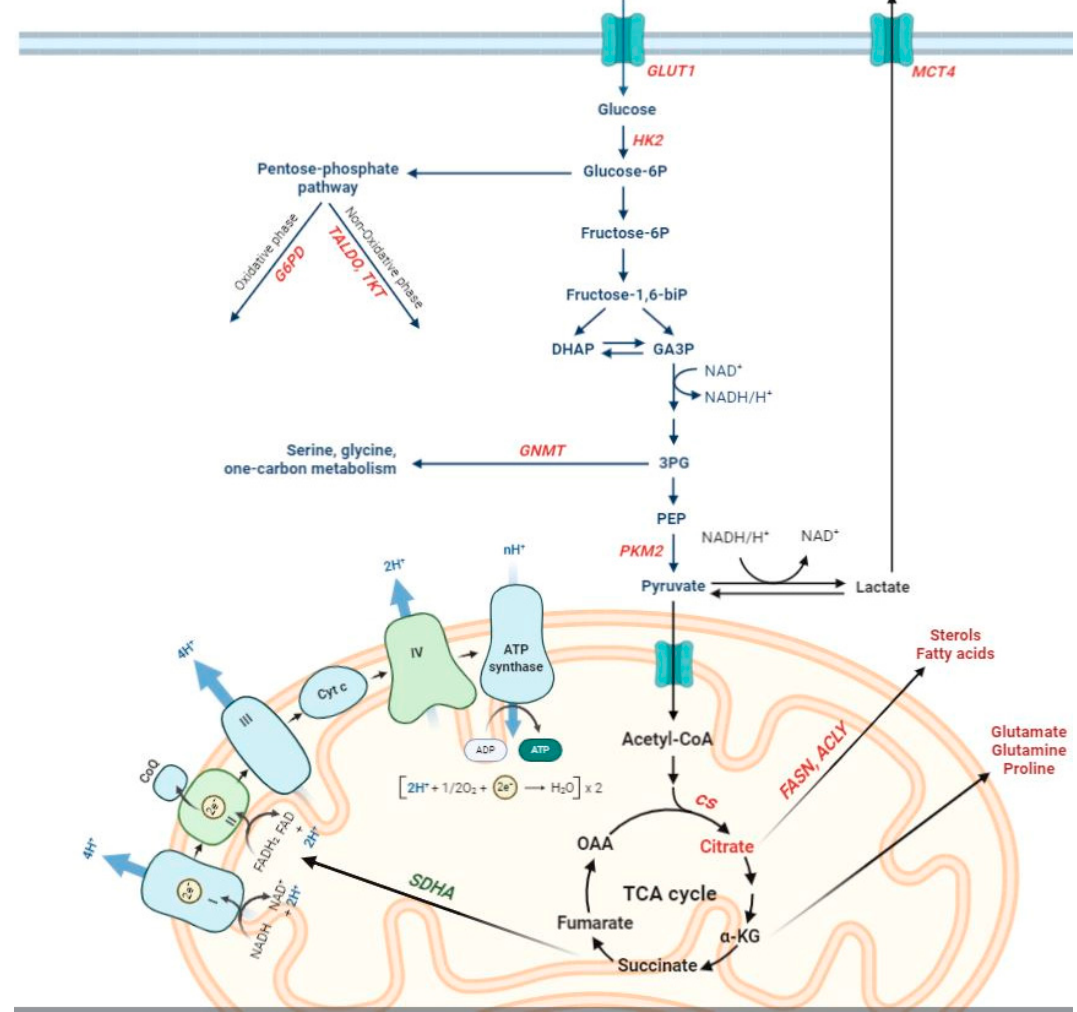
Figure 4. Schematic representation of altered biochemical pathways in rat preneoplastic nodules and HCC (red: up-regulation, green: down-regulation). The figure has been prepared by adapting BioRender images.